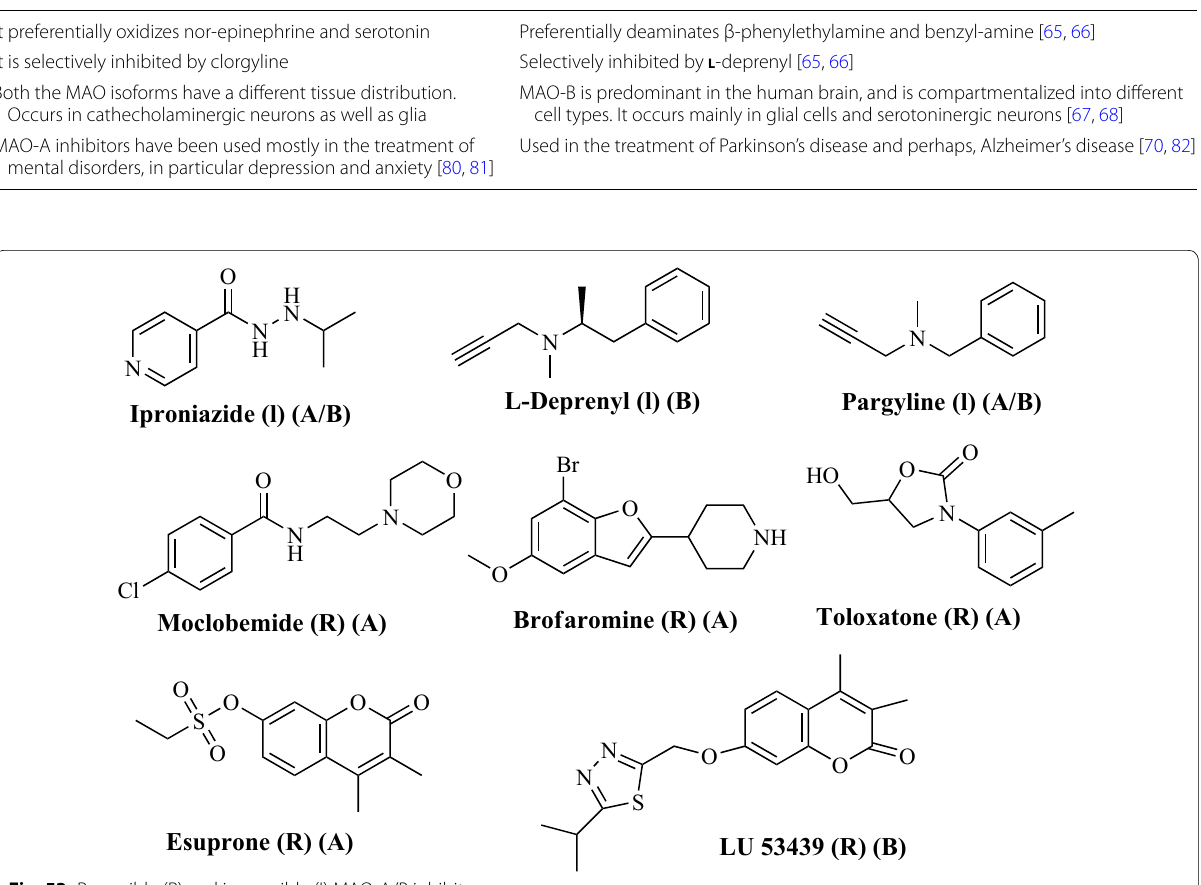
Table 1 Main difference between the two isoforms MAO-A and MAO-B MAO‑A MAO‑B It preferentially oxidizes nor-epinephrine and serotonin